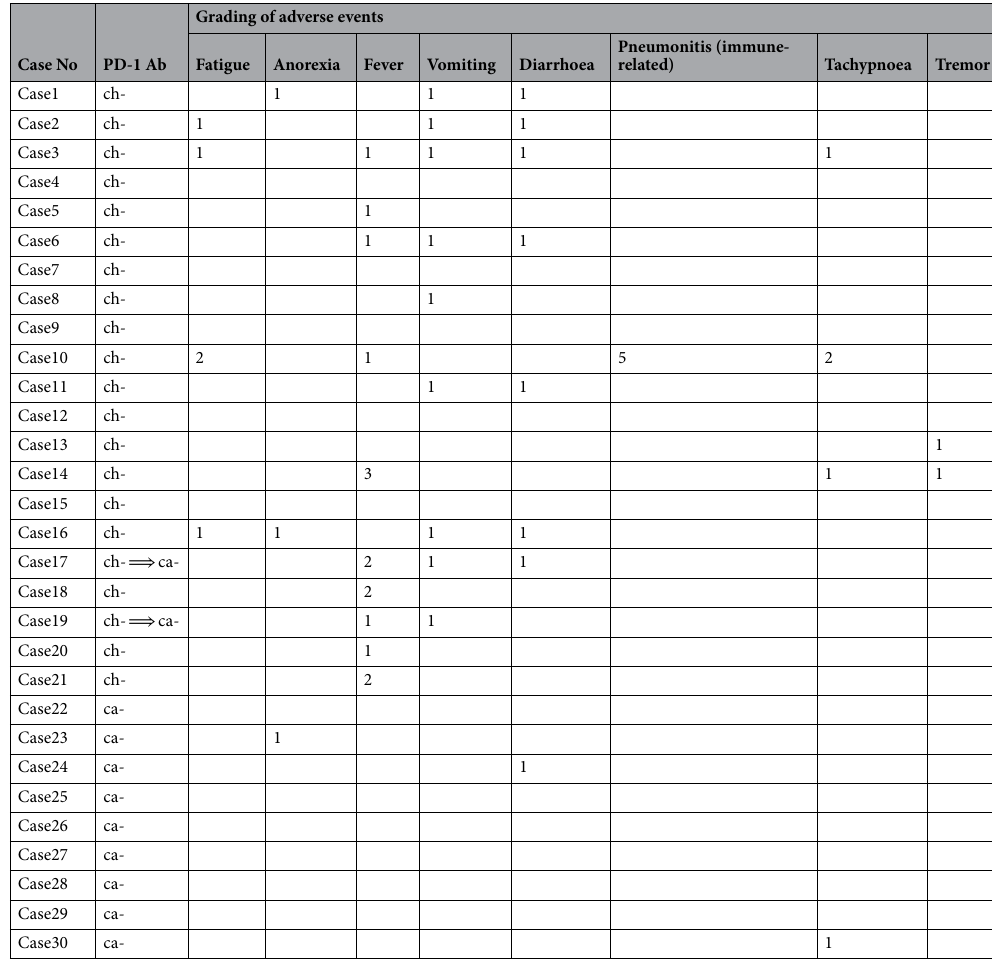
Table 2. Treatment-related adverse events in all enrolled